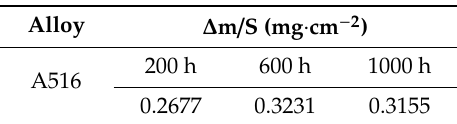
Table 4. Weight change per surface area of the samples removed after 200 h, 600 h and 1000 h exposure in the corrosion test at 390 ◦ C.